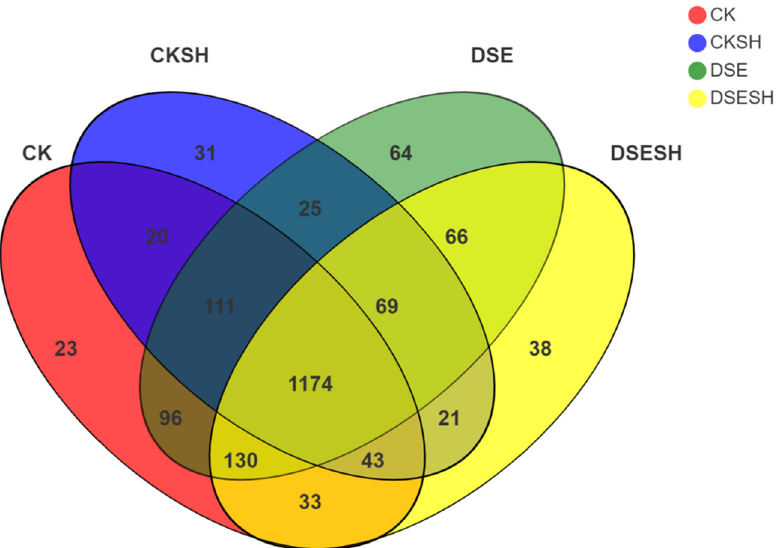
Figure 3. Venn diagram presenting the common OTUs under CK, CK + SH, DSE, DSE + SH treatments.